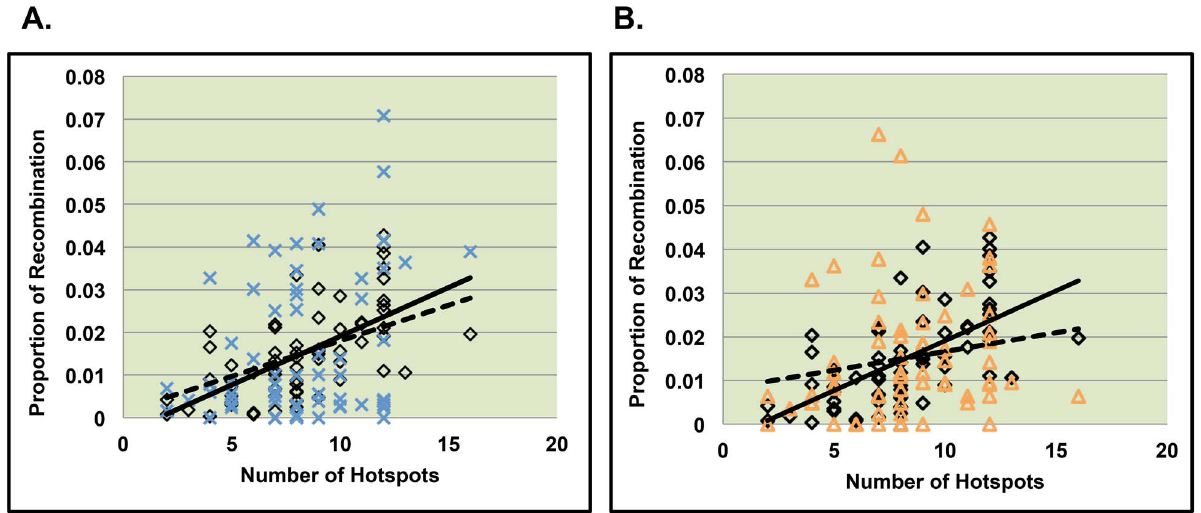
Figure 4. Comparison of the relationship between hotspot usage between MI and MII cases and Controls. Figure 4A and 4B represent MI and MII cases respectively with only one recombinant event on 21q. The solid line represents the relationship between the number of hotspots per bin and the proportion of recombination per bin along normally segregating chromosomes 21. The dotted line represents the relationship between the number of hotspots per bin and the proportion of recombination per bin along chromosomes 21 from MI errors (figure 4A) and MII errors (figure 4B).